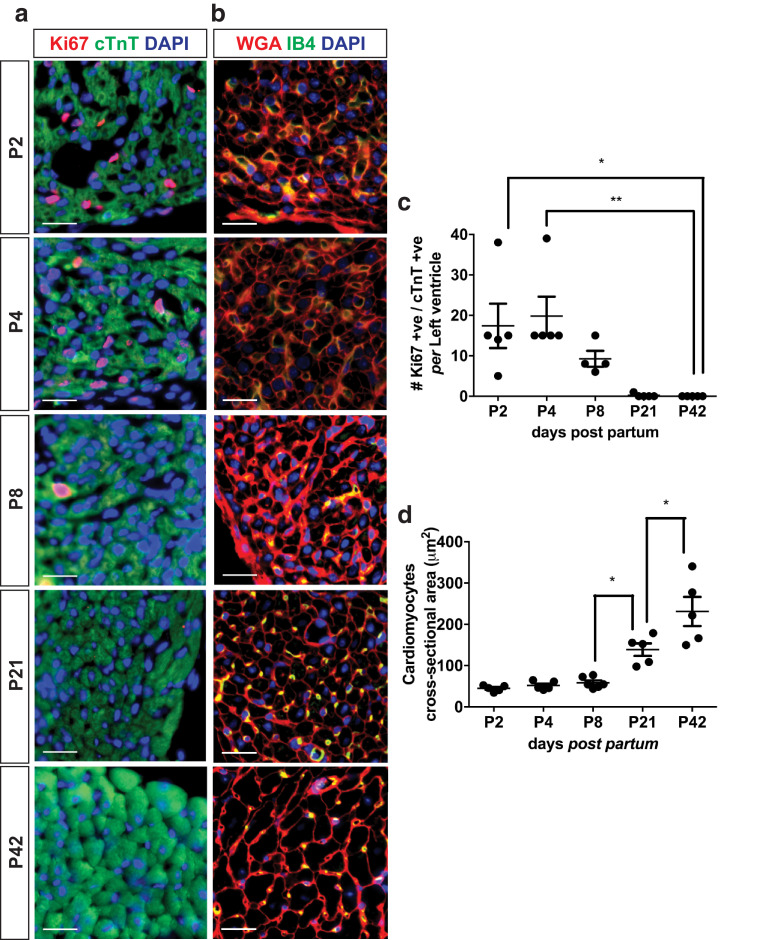
Distinct phases of growth of the post-natal mouse heart. Proliferative cardiomyocytes were identified as positive for anti-cardiac troponin T (cTnT; green-cardiomyocytes marker) and containing a nucleus, 4′,6 diamino-2-phenylindole (DAPI; blue), positive for Ki67 (red-proliferation maker) (a). Double-positive nuclei appear pink. Quantification was performed on five different field of views across the whole left ventricle of 4 μm thick cardiac sections. Cardiomyocyte cross-sectional area (CMCSA) (b) was investigated on wheat germ agglutinin (WGA; red-membrane marker), isolectin B4 (IB4; green-endothelial cells marker) and DAPI (blue) stained 4 μm thick sections. Vessels appear yellow as double positive for IB4 and WGA. Quantification of CMCSA was performed on five different fields of view within the outer layer of the left ventricle where cardiomyocytes are perpendicular to the plan of section. Scale bars = 20 μm. (c) Cardiomyocyte proliferation quantification; (d) CMCSA quantification. All measurements were performed at post-natal day 2 (P2), P4, P8, P21 and P42; n = 3–5/group. Results are presented as mean ± standard error of the mean; p value determined with one-way analysis of variance with Bonferroni post hoc test. *p < 0.05, ***p < 0.001.